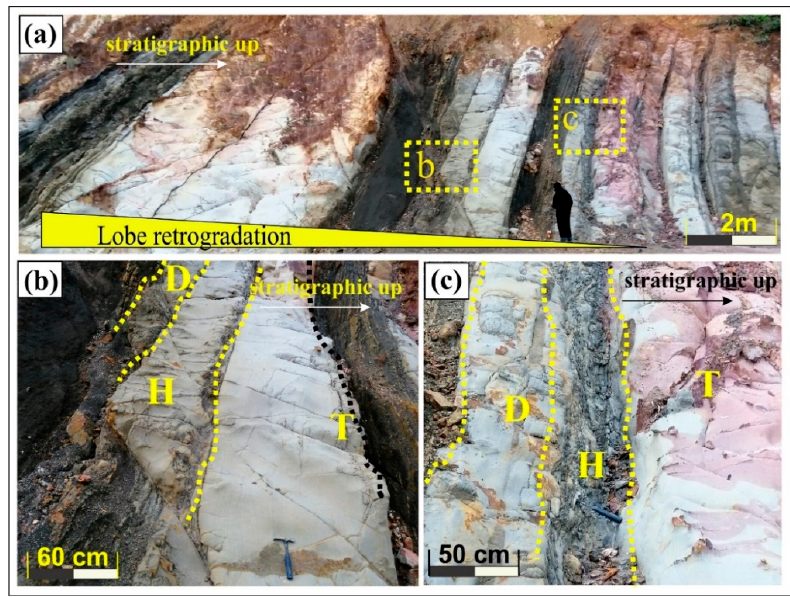
beds are sporadically distributed in a compensational stacking pattern while these hybrid event beds are mainly present at the top of the retrogradational sequence (Figure 11) of a lobe system [41].